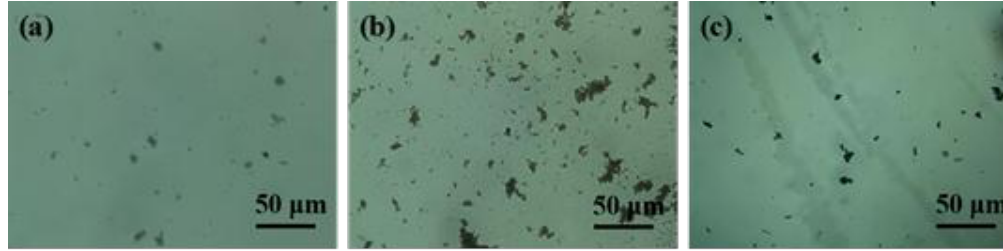
Figure 2. Optical microscope images of tetrahydrofuran (THF) suspensions with ( a ) GnPs-OH; ( b ) MWCNTs-OH; ( c ) hybrid materials at a filler concentration of 0.1 mg/mL. ( b ) MWCNTs-OH; ( c ) hybrid materials at a filler concentration of 0.1